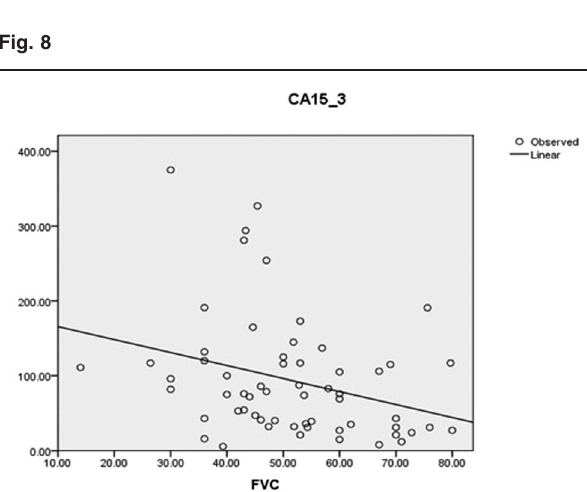
Correlations between carbohydrate antigen 15-3 and age,forced vital capacity, and forced expiratory volume in first second/forced vital capacity in the three groups.